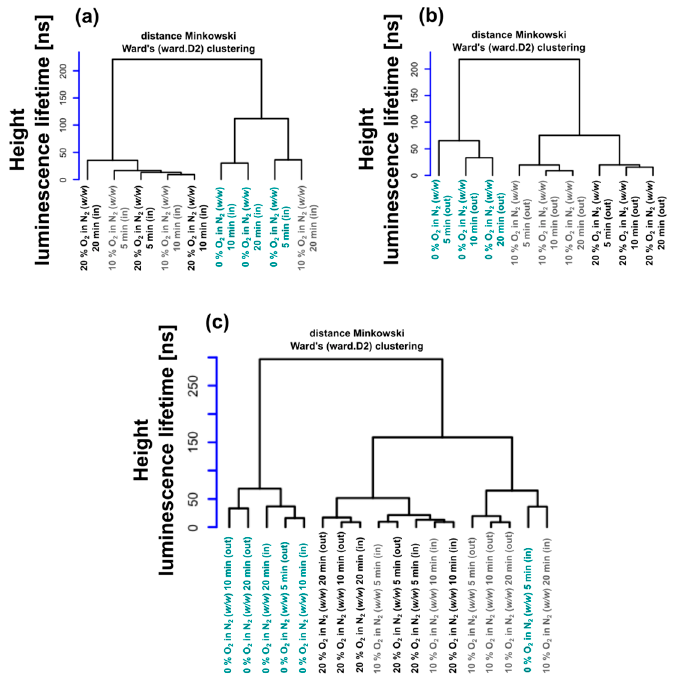
Figure 3. Dendrograms of [Ru(Phen) 3 ] 2+ luminescence lifetime detected ( a ) in the blood vessels and ( b ) out of the blood vessels of the CAM at 5, 10, and 20 min after iv administration and with O 2 in N 2 ( w / w ) atmosphere ranging between 0% and 20%. ( c ) The dendrogram, which is derived from the whole dataset showing mutual